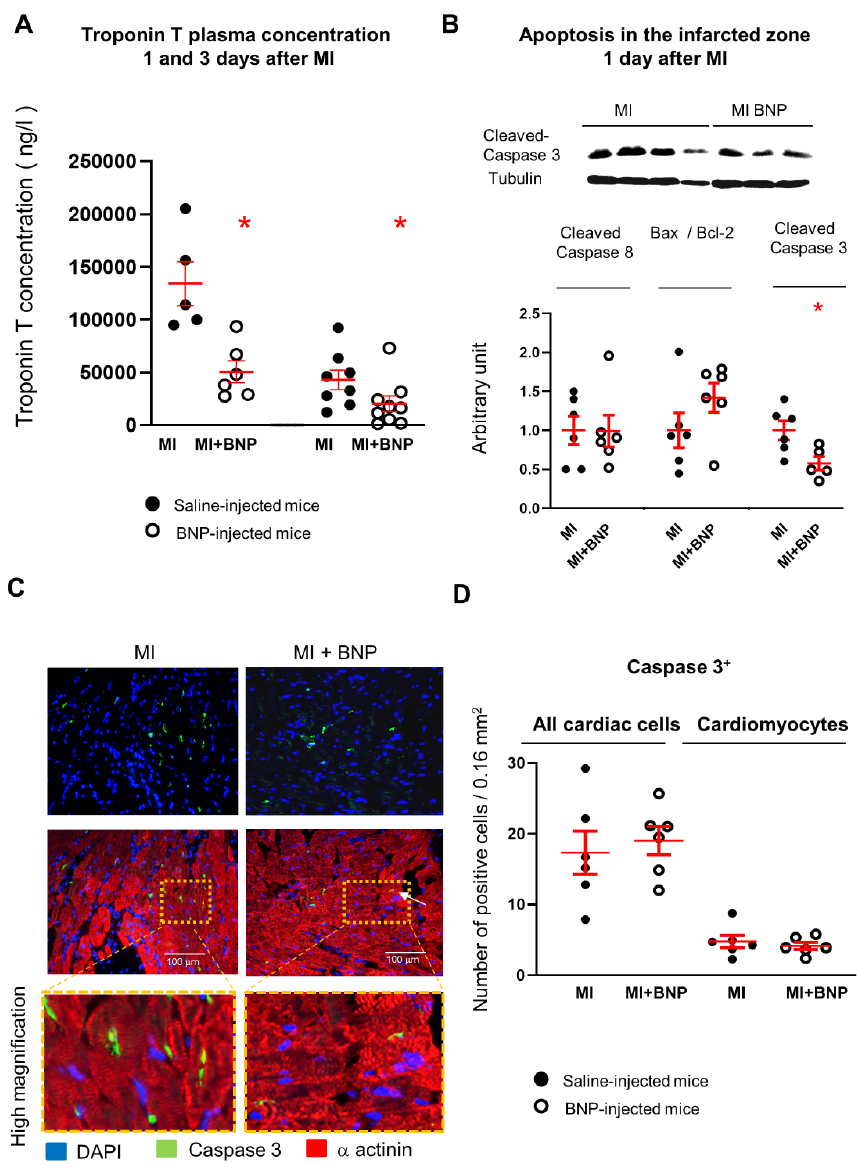
Figure 4. BNP treatment protects cardiac cells in the ZI of infarcted hearts. ( A ) Troponin T plasma concentration 1 and 3 days after myocardial infarction. Plasma were collected from 5 saline and 6 BNP-treated infarcted mice 1 day after MI and from 7 saline- and 8 BNP-treated infarcted mice 3 days after MI, respectively. ( B ) Representative Western blot of total proteins extracted from the infarcted area (ZI) of hearts treated with BNP (MI+BNP) or saline (MI) 1 day after surgery. Blots stained with antibodies against cleaved caspase-3 and Tubulin (used as loading control). Only the bands at the adequate molecular weight represented here: Tubulin (55 kDa), cleaved caspase-3 (12 kDa). Quantification of Western blot analysis for the cleaved caspase-8, the ratio Bax/Bcl-2 and cleaved caspase-3, all related to tubulin in BNP- and saline-treated hearts. n = 6 different saline- or BNP-infarcted hearts. Quantification of the data in BNP-treated infarcted hearts related to the average of saline-injected infarcted hearts. ( C ) Representative pictures of infarcted hearts injected or not with BNP and stained with antibodies against cleaved caspase-3 (green) and α -actinin (red). High magnifications depict apoptotic CMs in the ZI. ( D ) Graph represents the total number of cells and the number of cardiomyocytes expressing cleaved caspase-3 per picture in the infarction zone, one day after MI in BNP— and saline-treated mice. Positive cells counted from at least 10 different pictures per heart and n = 6 saline- and 6 BNP-treated infarcted hearts. For all results, individual values represented and the means ± SEM depicted in red. * p ≤